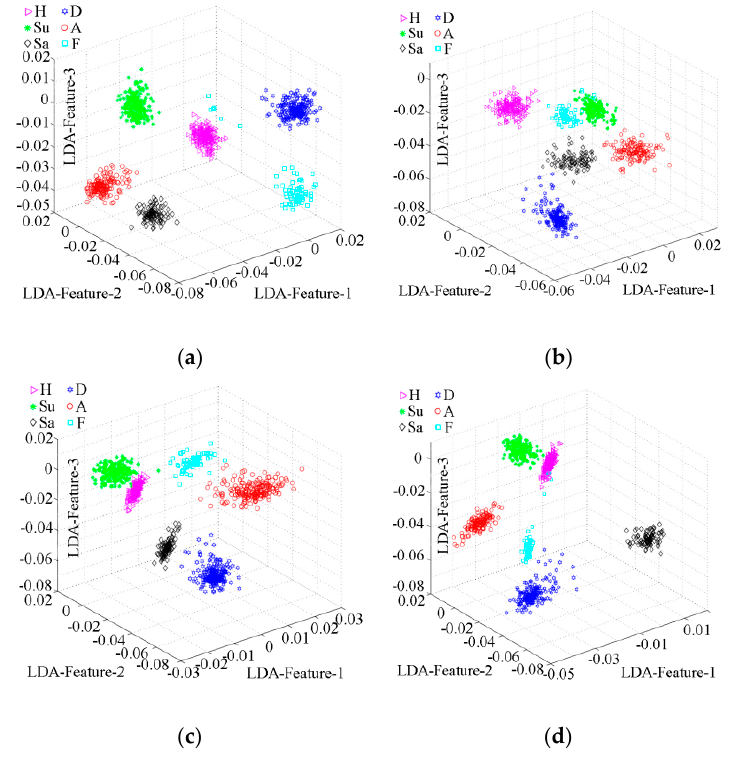
Figure 3. 3D feature plots of the proposed method for recognizing the expressions on the four datasets: ( a ) Japanese Female Facial Expression (JAFFE) dataset, ( b ) extended Cohn-Kanade (CK+) dataset, ( c ) MMI Facial Expression (MMI) dataset, and ( d ) Psychological Image Collection at Stirling (PICS) dataset. Table 1. Comparison of average accuracy rate of the proposed method with and without feature selection on the four data sets.